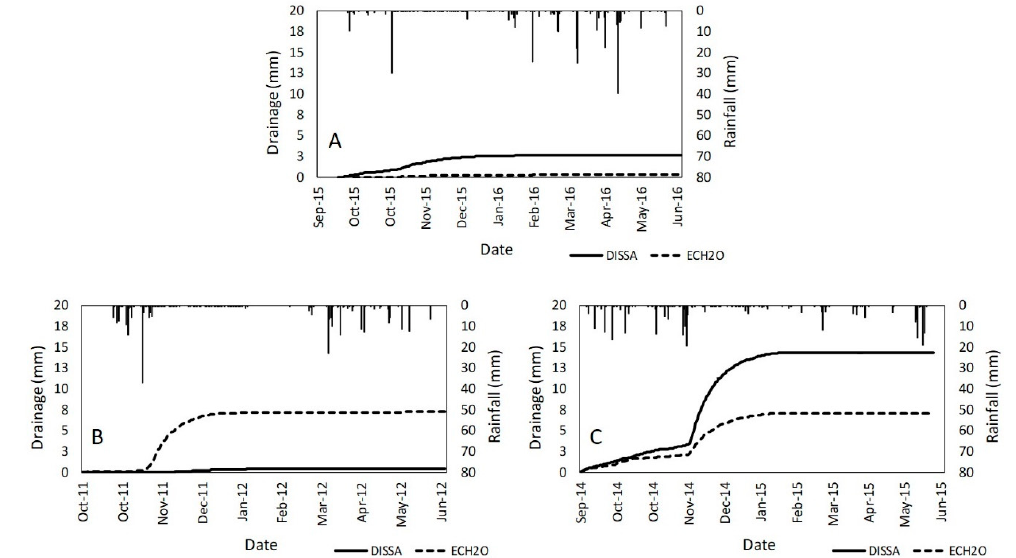
Figure 9. Accumulated drainage at 90 cm simulated with LEACHM model for calibration ( A ) and validation ( B,C ) periods using different data set (continuous line from disturbed soil samples and dashed line from ECH2O sensors) during three barley crop seasons.